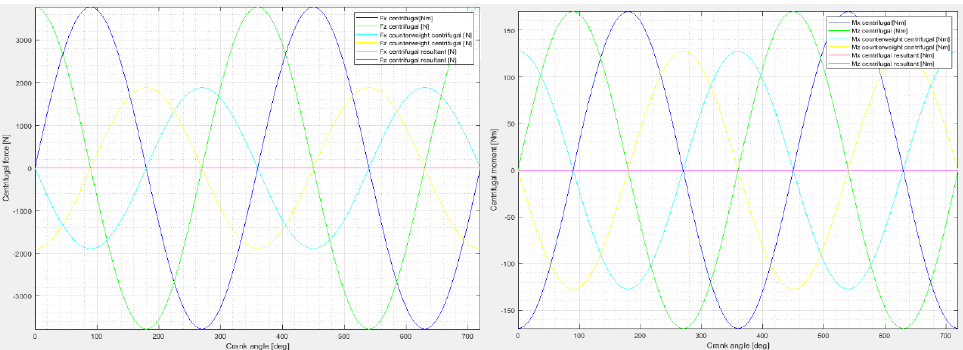
Figure 15. Centrifugal forces ( left ) and moments ( right ) for a 4 cylinder V-engine.